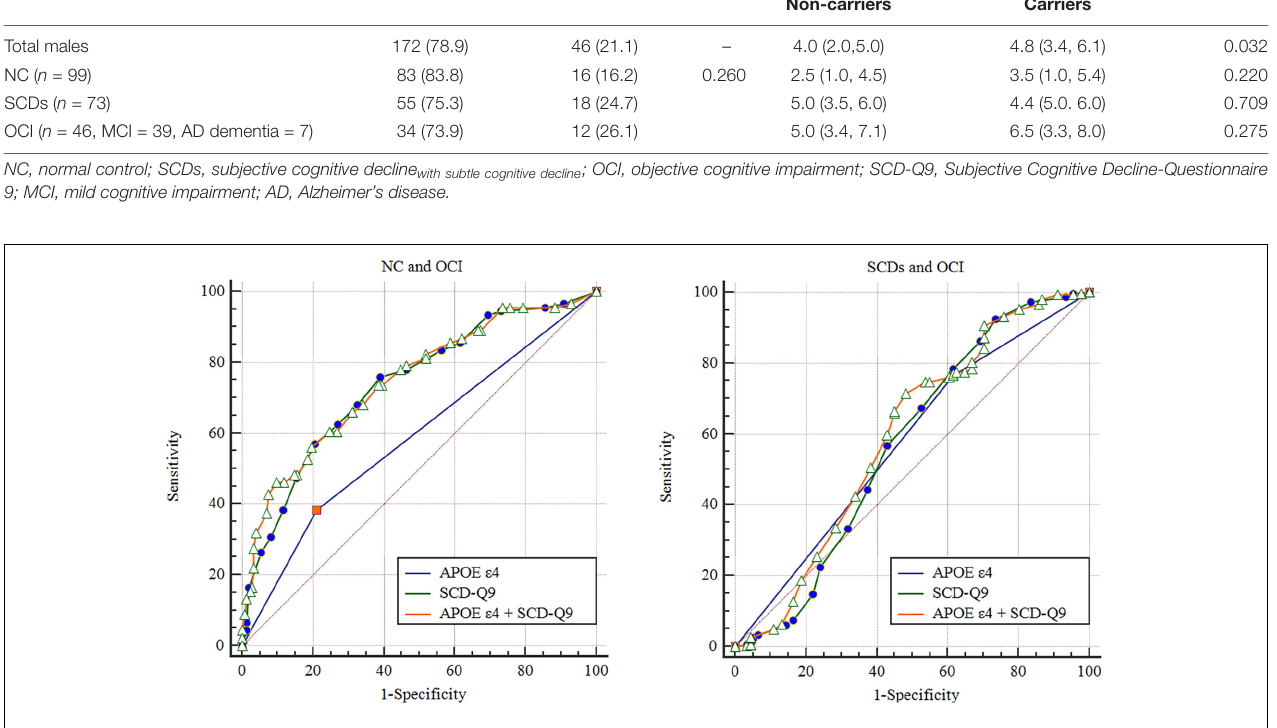
FIGURE 1 | Receiver operating characteristic of NC, SCDs, and OCI groups. NC, normal control; SCDs, subjective cognitive decline with subtle cognitive decline ; OCI, objective cognitive impairment; SCD-Q9, Subjective Cognitive Decline-Questionnaire 9; ROC, receiver operating characteristic.